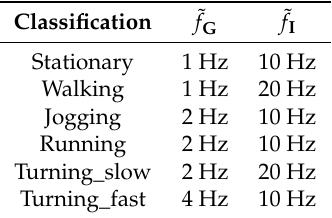
Table 6. Near-optimal sensing-rate configurations from Algorithm